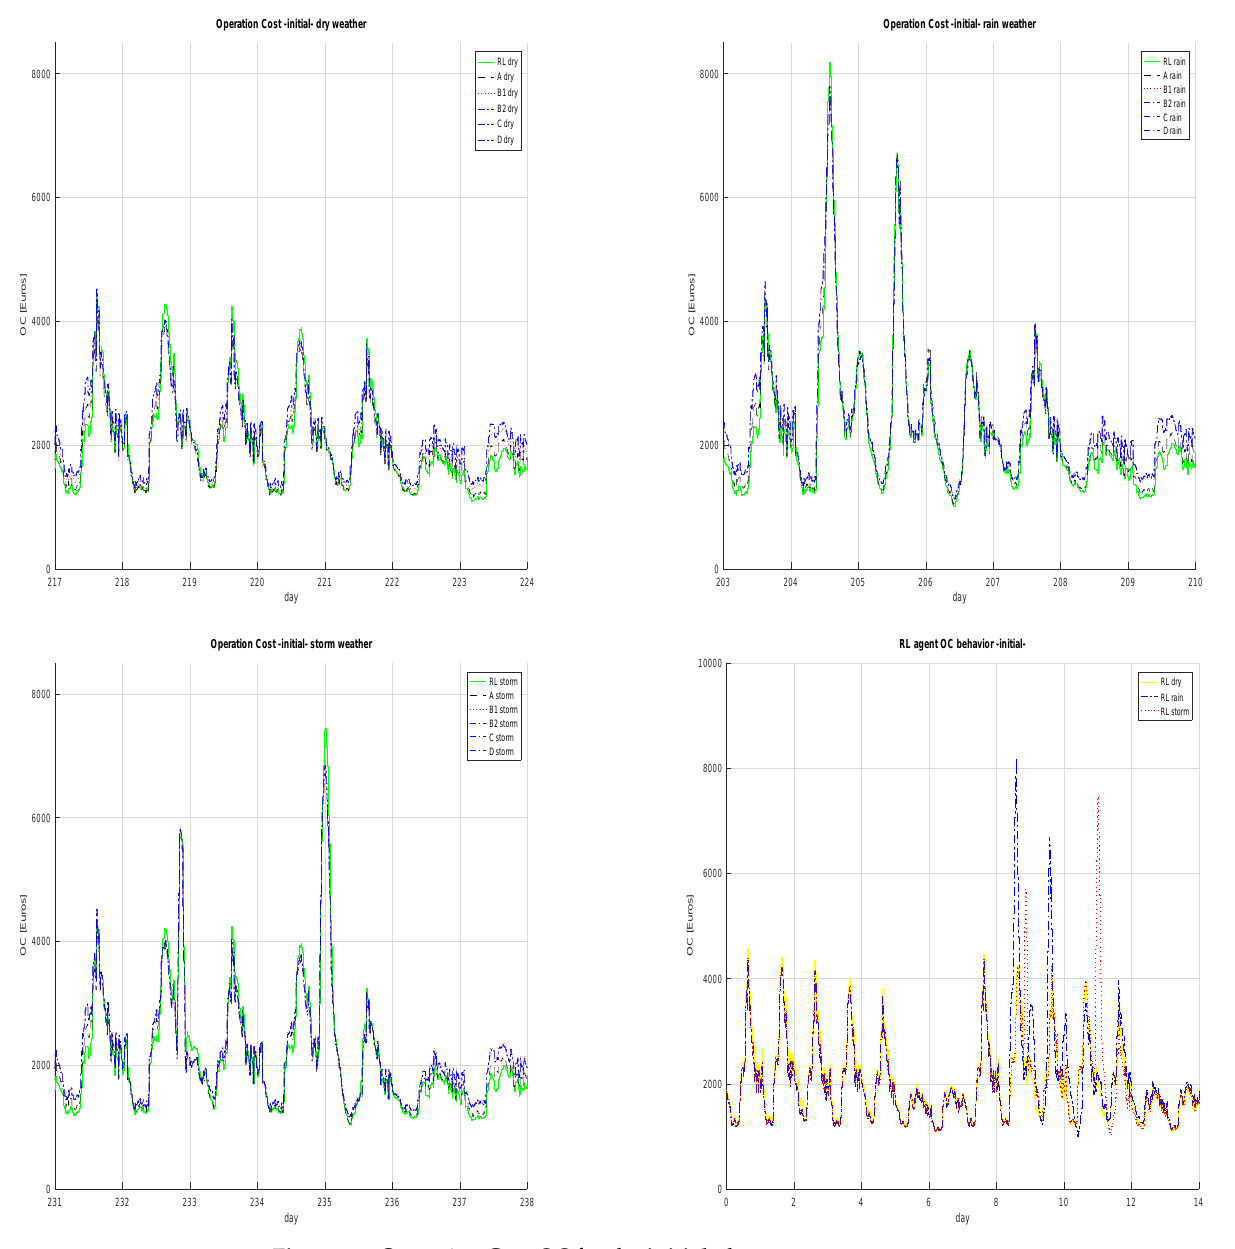
Figure 13. Operation Cost OC for the initial